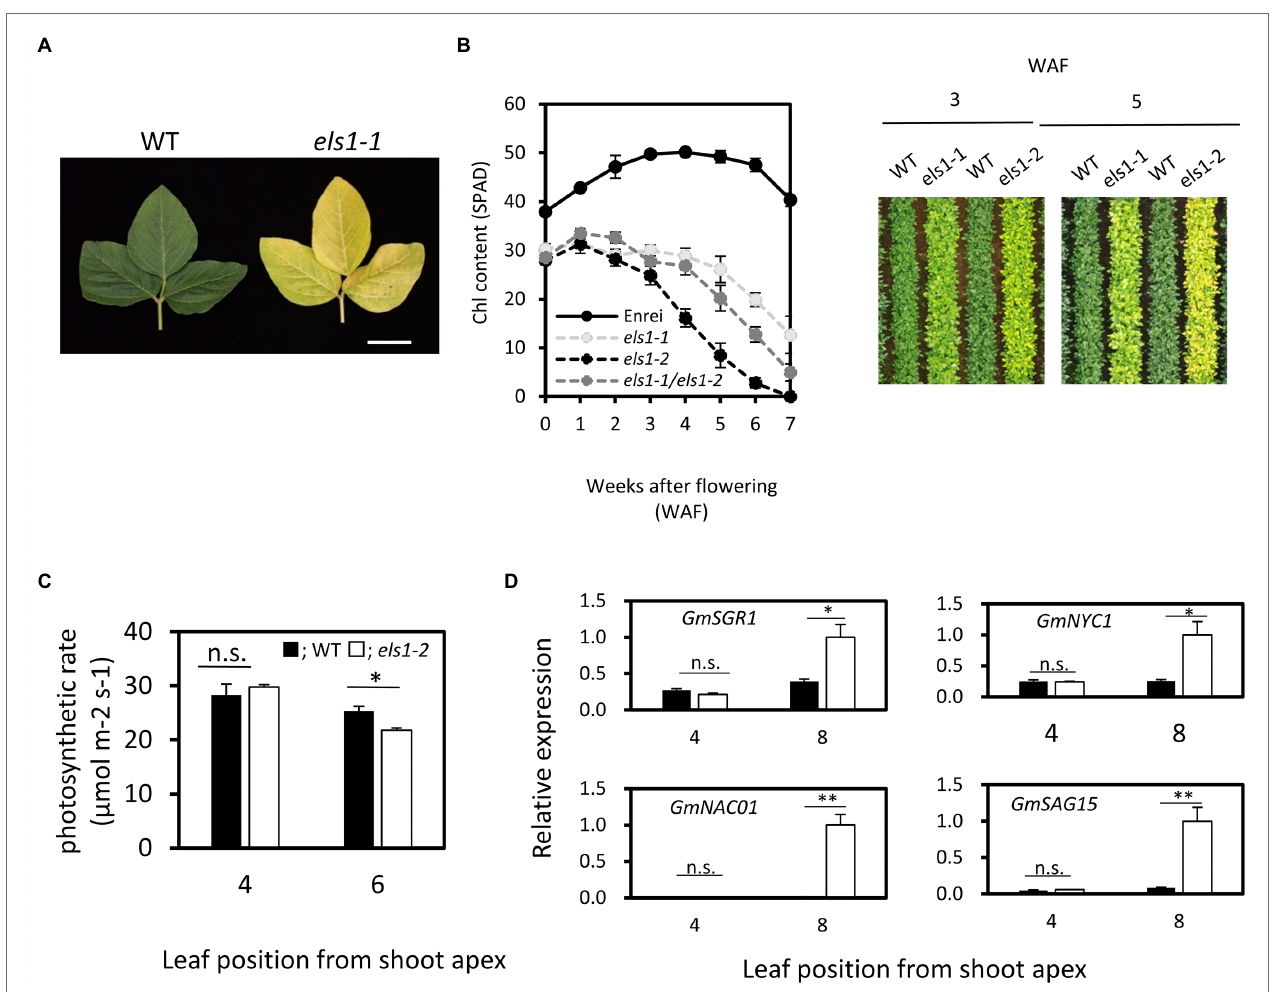
FIGURE 1 | Physiological characterization of els1 during natural leaf senescence. (A) els1-1 showed an early yellowing phenotype compared to WT during natural leaf senescence. The photo shows the upper 4th leaves at 5 weeks after flowering. The scale bar indicates 5 cm. (B) Time course of chlorophyll content in els1 during natural during natural leaf senescence. The chlorophyll content (SPAD) of upper 4th leaves was measured from the flowering. Solid lines; Enrei, light gray dotted lines; els1-1 , dotted lines; els1-2 , dark gray dotted lines; heterozygote lines between els1-1 and els1-2 . The error bars indicate the standard error (SE) (n = 6 biological replicates). The right panels were aerial photographs taken by a drone at 3 and 5 weeks after flowering. (C) The carbon assimilation rates of pre-senescent (the upper 4th leaves) and senescent (the upper 6th leaves) leaves (n = 5 biological replicates) of WT and els1-2 . Black bars indicate WT, white bars indicate els1-2 . Error bars indicate standard error (SE). * p < 0.05, ** p < 0.01, n.s., not significant (Student’s t-test). (D) Expression pattern of senescence-inducible genes in WT and els1-2 during natural leaf senescence. Total RNA from pre-senescent (the upper 4th leaves) and senescent (the upper 8th leaf) leaves of WT and els1-2 were examined. Expression levels were standardized using GmACTIN (n = 6 biological